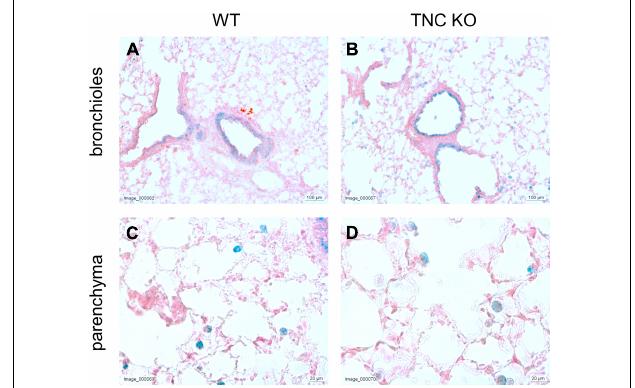
FIGURE 5 | Senescent cells in old TNC-deficient and WT lungs. Senescence-associated beta-galactosidase activity was evaluated on 5 µ m cryosections of old TNC KO and WT mice inflated with O.C.T. Compound. Representative images of lung sections from old WT (A,C) and TNC KO (B,D) animals stained for senescence-associated beta-galactosidase activity (blue) and counter-stained with Nuclear Fast Red. N = 3